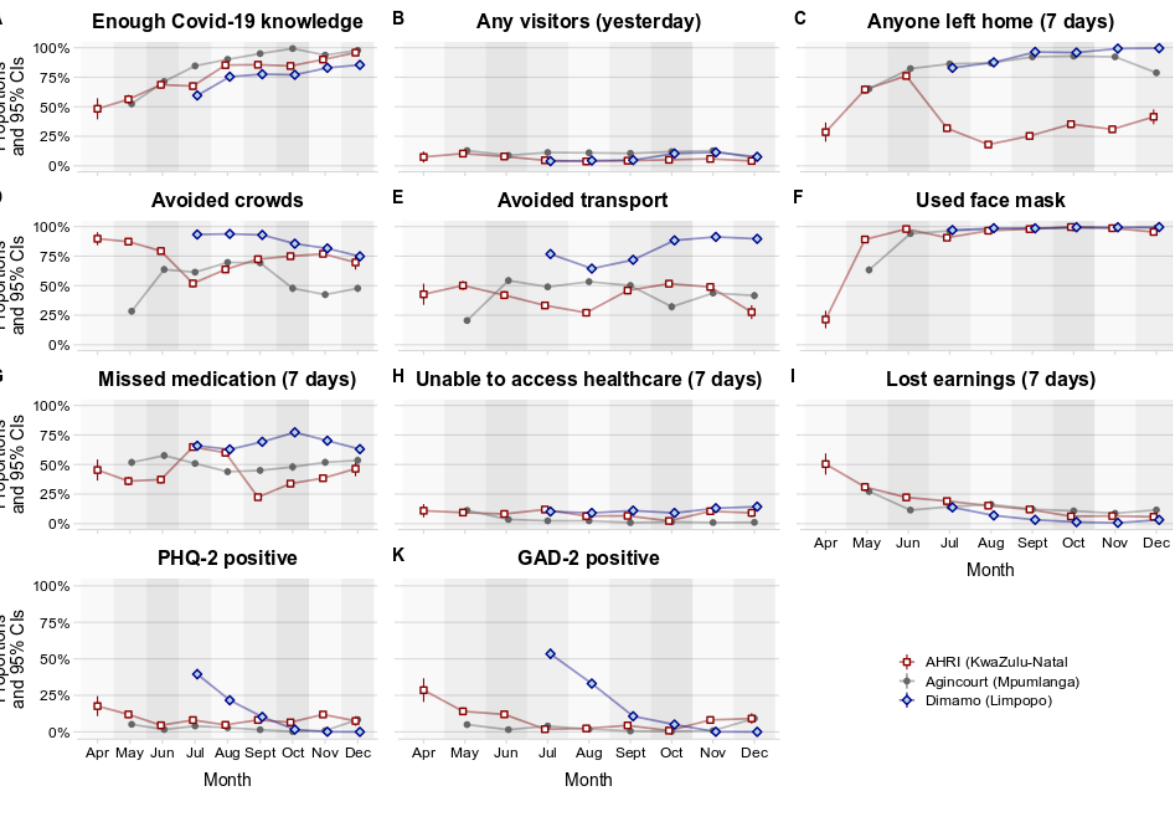
Figure 2. Knowledge about, behavior relating to, and impact of COVID-19 and related regulations at South African Population Research Infrastructure Network nodes from April to December 2020. Graphs A, D, E, F, J, and K reflect individual-level responses of the primary household respondents. Graphs B, C, G, H, and I reflect household-level responses reported by the primary household respondents. Values are proportions of household primary respondents and 95% CIs. Precise values are provided in Table S3 in Multimedia Appendix 1. AHRI: Africa Health Research Institute;